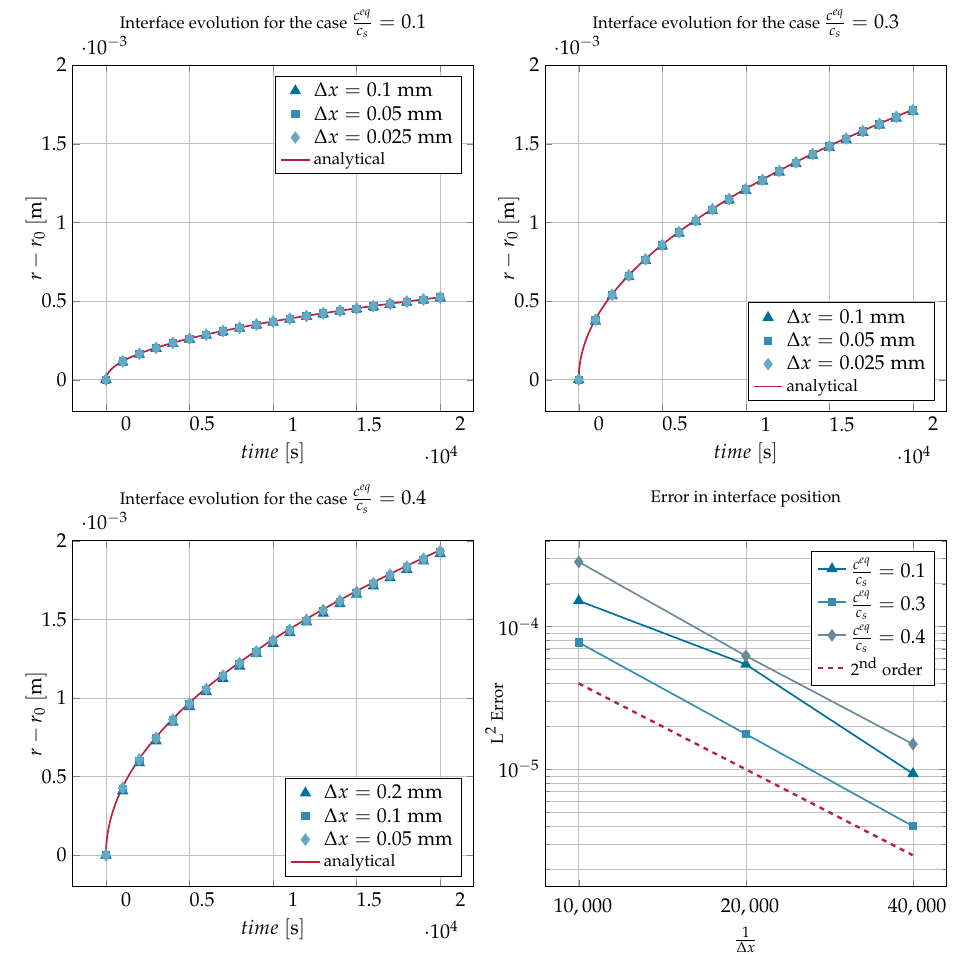
Figure 4. Comparison of the analytic solution and the simulated results for the position of the interface in the case of diffusion-controlled dissolution for different solid/fluid saturation ratios and for different grid resolutions together with a plot showing the convergence of the L 2 norm of the error in the interface